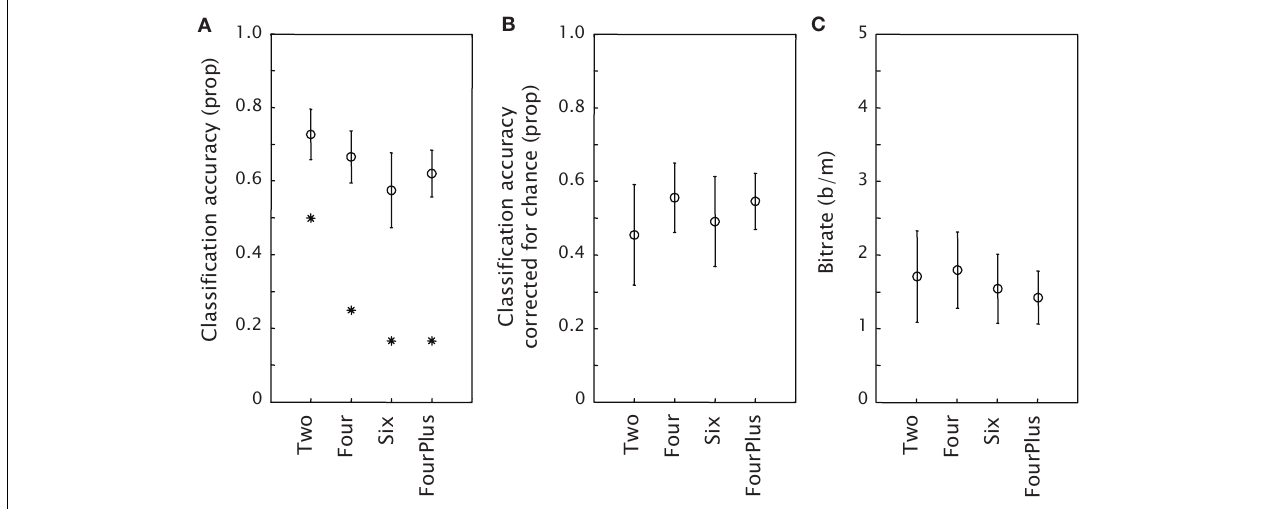
FIGURE 2 | Mean performance of the classifi cation model in the four conditions of Experiment 1 as expressed by classifi cation accuracy, or proportion of targets correct (A), classifi cation accuracy corrected for chance (B) and bitrate (C). The stars in (A) indicate chance performance. Error bars represent standard errors of the